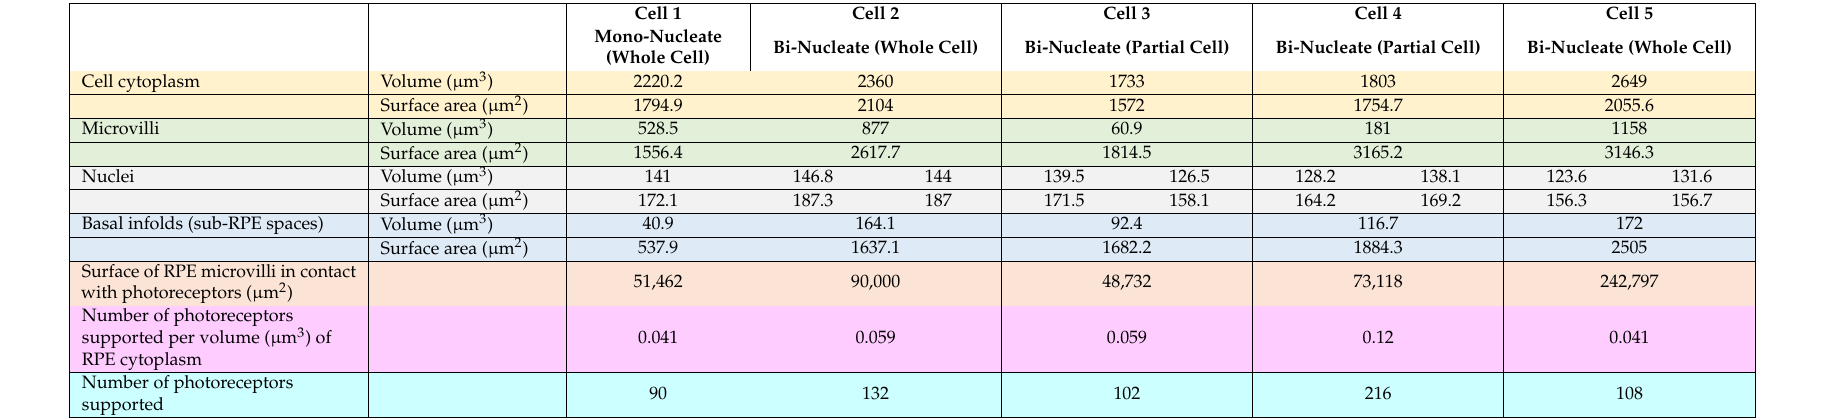
Table 1. Measurements from 3D-reconstructed